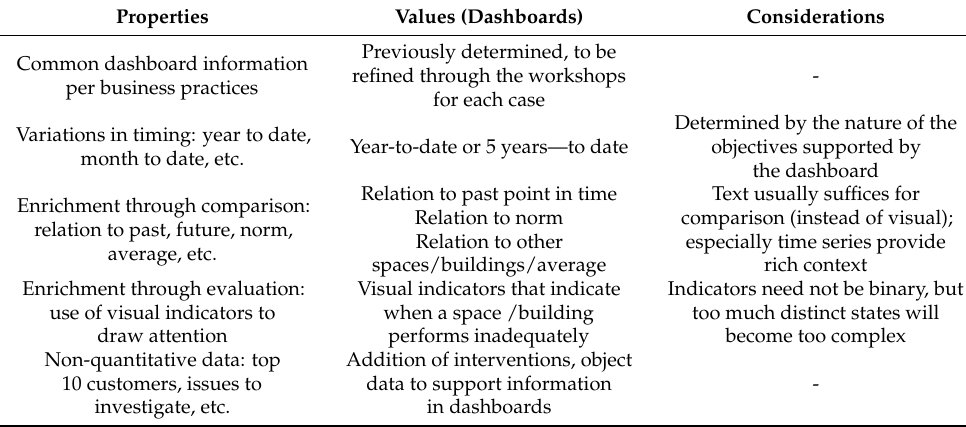
Table 2. Considerations for the display of information in dashboards (based on Few [19]).